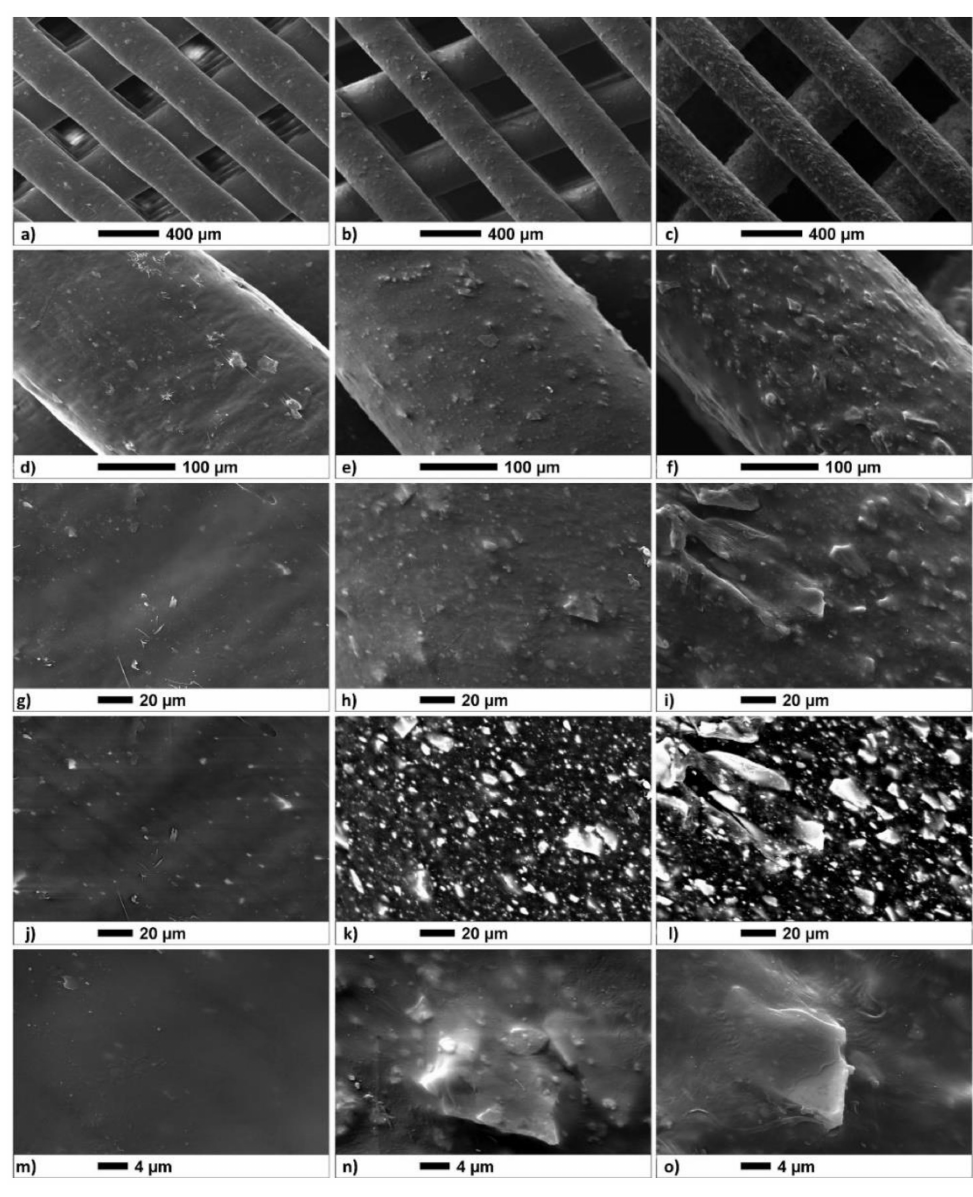
Figure 2. SEM images of top view of the ( a , d , g , j , m ) pure PCL, ( b , e , h , k , n ) 70/30, and ( c , f , i , l , o ) 50/50 compositions. Images were acquired by a secondary electron (SE) detector, except ( j – l ), which were achieved through a backscattering electron (BSE) detector, which localized the presence of heavy ions in the samples. Images ( g – i ) and ( j – l ) were acquired over the same area by the SE and the BSE,